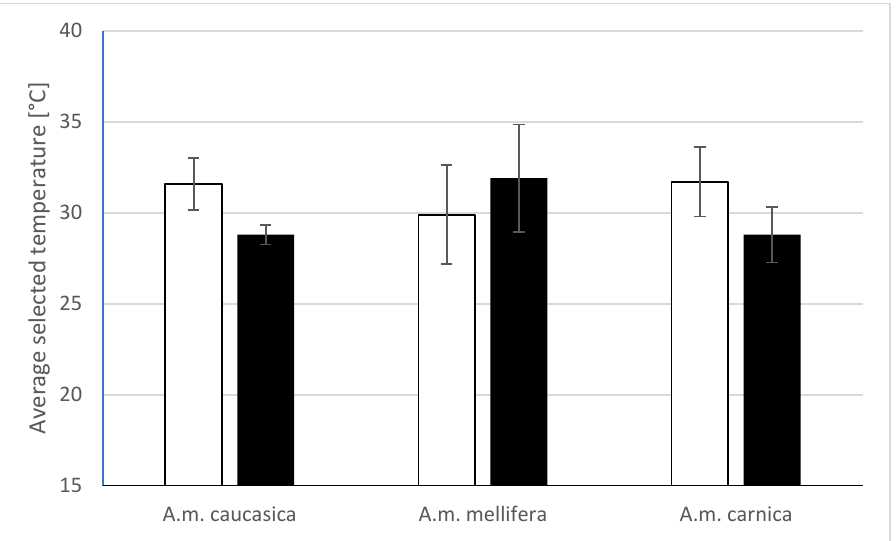
Figure 6. Average ambient temperature [°C] selected by bees born in autumn and spring. There was no statistical significance of differences in the mean ambient temperature selected between autumn bees preparing for wintering and summer bees both in the case of a given subspecies and between subspecies (F(2,28) = 3.97; p < 0.0303) (Figure 7). Because of the lack of differences between the subspecies, we can treat thermoregulatory behaviour as representing a feature characteristic of the entire honeybee ( Apis mellifera L.) species.